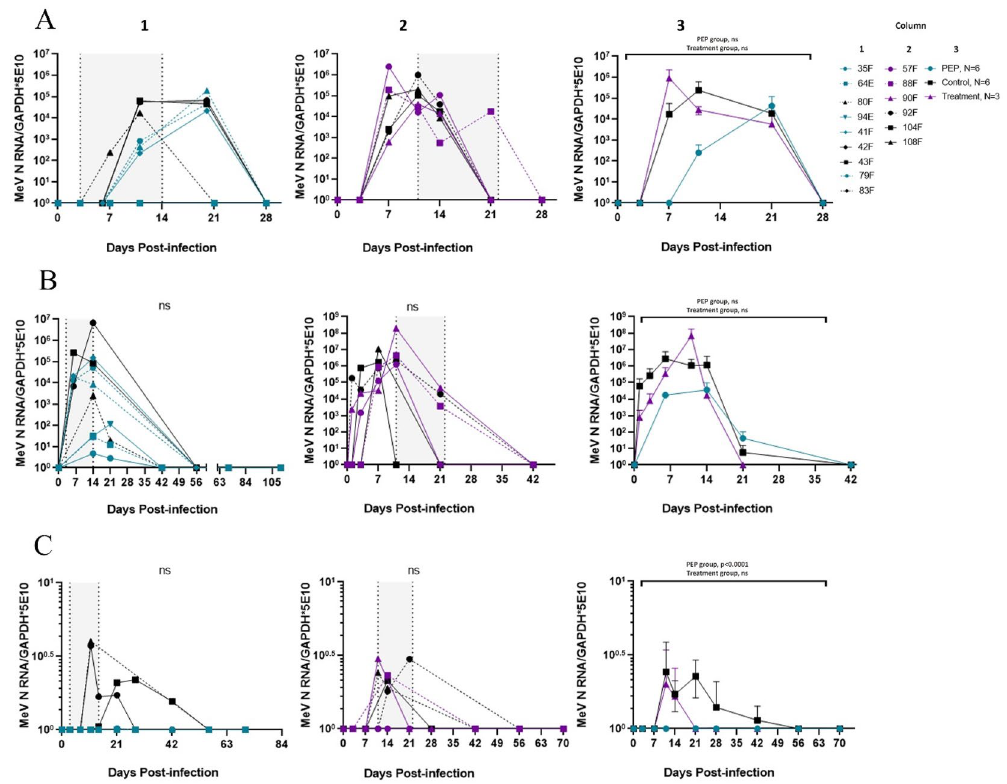
Figure 3. MeV N RNA in respiratory samples and urine. MeV N RNA detected by RT-qPCR in RNA extracted from ( A ) Nasal swab pellet cells, ( B ) 1 × 10 6 BAL cells and ( C ) urine. Column 1: Individual data from PEP study group and untreated controls; Column 2: Individual data from late treatment study group and untreated controls; Shaded areas indicate treatment periods. Column 3: Averaged data with pooled untreated